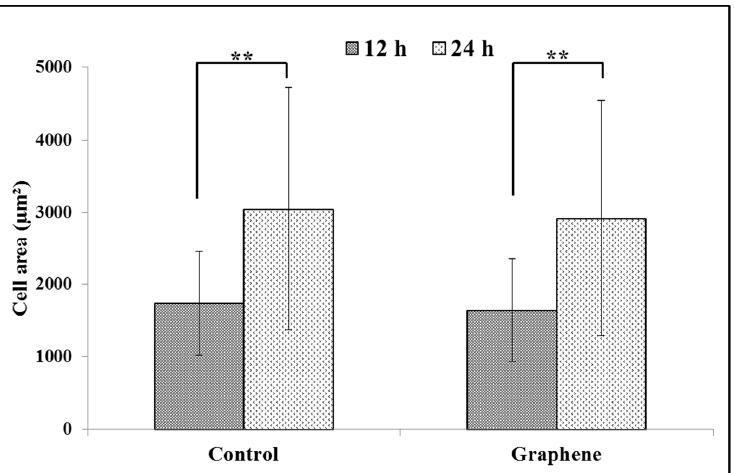
Figure 4. Spreading (cell area) of BALB/3T3 fibroblasts 12 and 24 h after seeding on glass and graphene platform. Data are represented as mean ± SD (standard deviation) of three independent experiments. Approximately 70 cells were evaluated in each experiment. Single cell-area was measured using ImageJ software. ** - statistically significant differences.